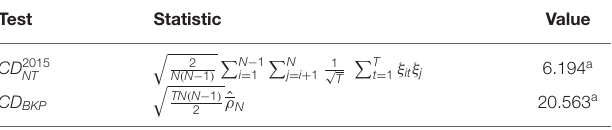
TABLE 3 | Tests for cross-sectional dependence in residuals. Test